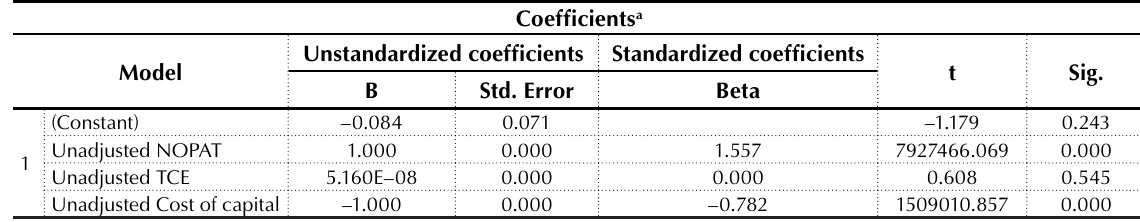
Table 3. Coefficient test for individual